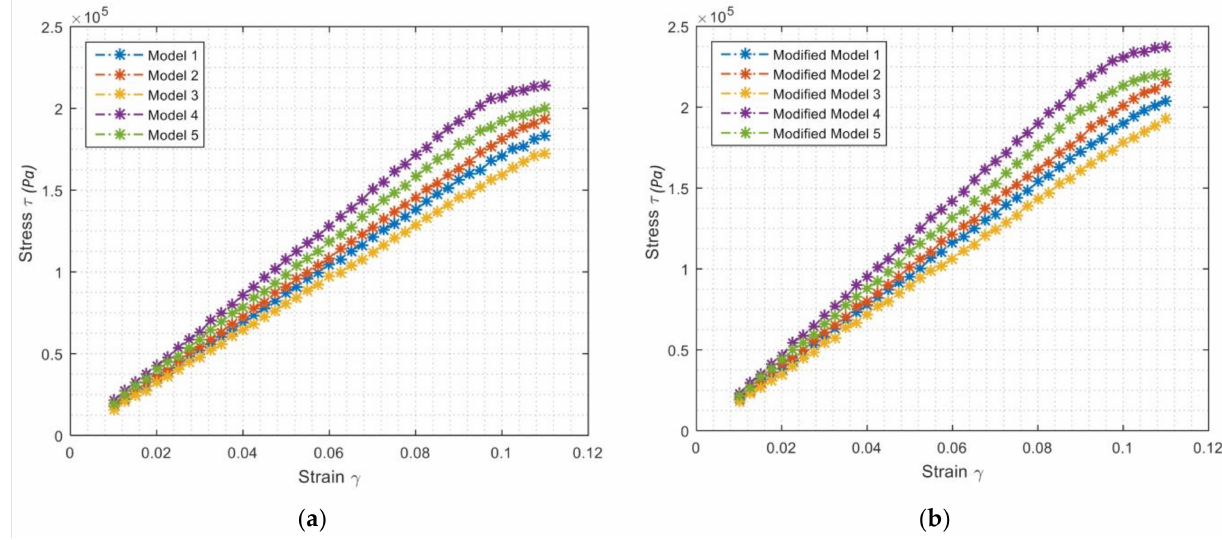
Figure 3. Stress-Strain Curve of Initial modulus from M1-M5, ( a ) for MER are1.74, 1.81, 1.62, 2.13, and 1.96 MPa, ( b ) for MER with MWCNTs are 1.94, 2.03, 1.77, 2.38, and 2.17